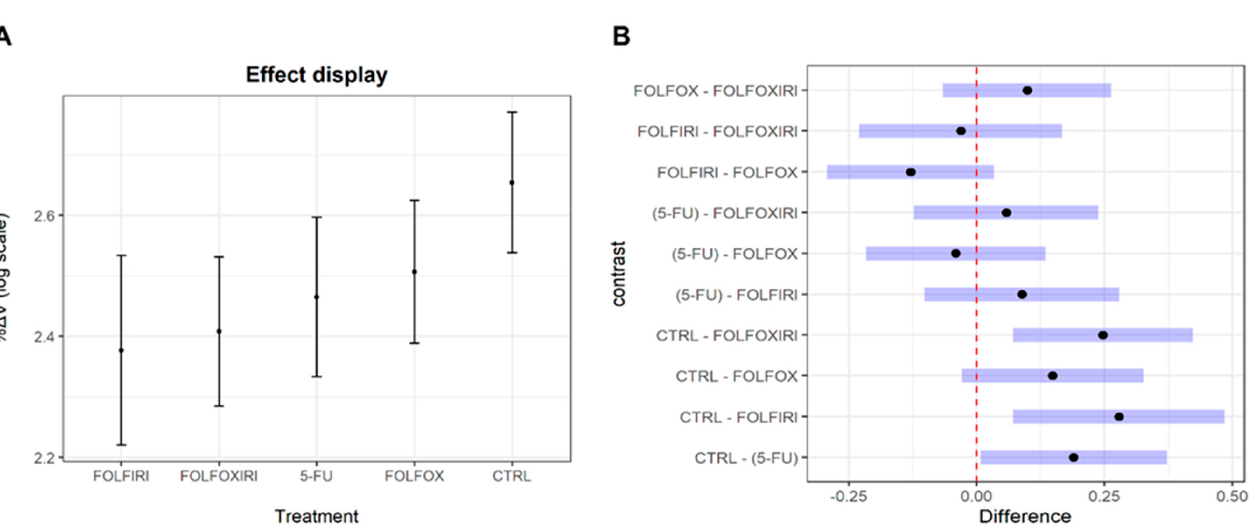
Figure 3. Clustering of colorectal cancer patients according to k-means and principal component analysis.